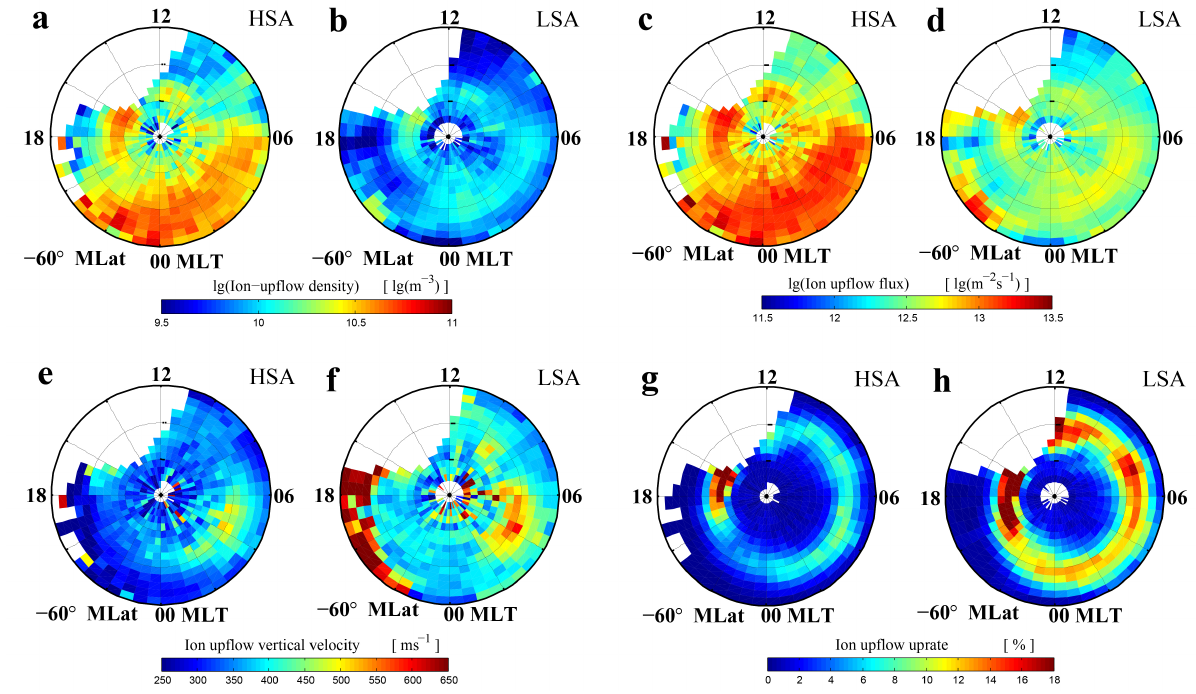
Figure 3. Spatial distribution of upflow parameters as a function of MLat running from −60 ∘ to −90 ∘ in 2 ∘ steps and MLT in steps of 0.5 h, for high (a, c, e, g) and low (b, d, f, h) solar activity, respectively. (a, b) Ion upflow density, (c, d) ion upflow flux, (e, f) ion upward velocity, and (g, h) upflow occurrence frequency. The average time period is from March 1996 to December 2005. Note that legends shown in panels a-d are logarithmically